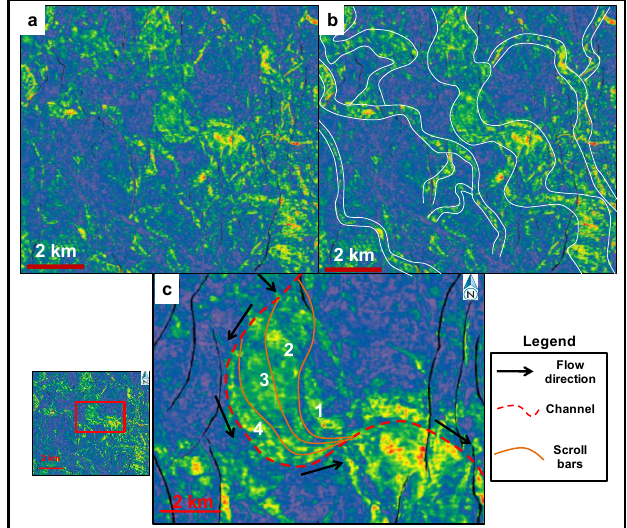
Figure 6: High RMS value has been interpreted as sands associated with meander belts in Horizon slice B+80 (a). The interpretation shows various meander belts (b). Flow directions from scroll bar accretion (c).